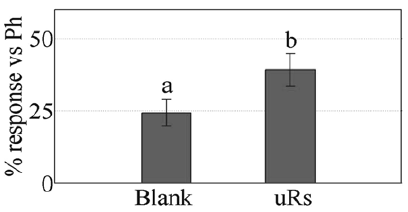
Figure 7. Mean percentage of the EAG response from 10 insect antennae to the blank and the pheromone released from the microreactors (‘‘uRs’’) relative to the response to 10 m g of synthetic pheromone.